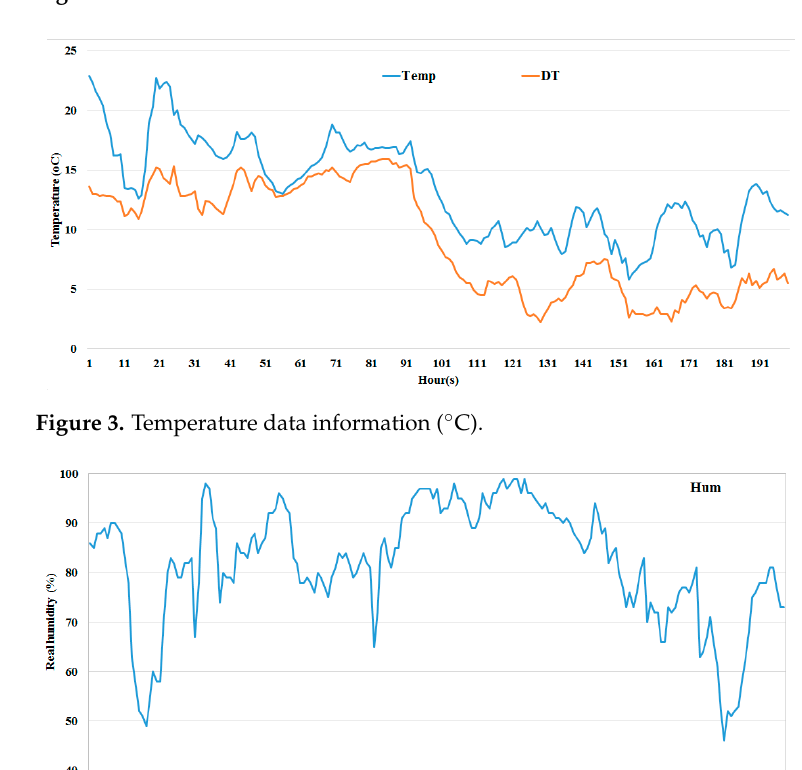
Figure 2. Load data information in MW.